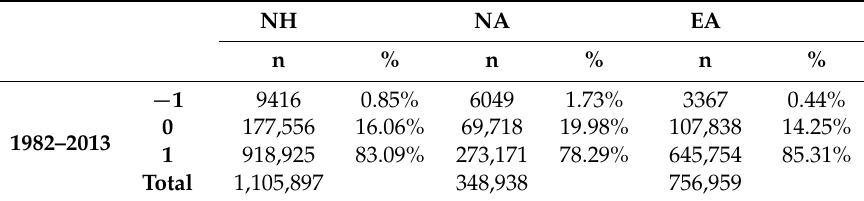
Figure 5. Map of r-values for correlations between length of vegetation growing season (LOS) and growing season NDVI integral (GSI) 1982–2013. Table 3. Statistics (number of pixels and percentages) of significant correlations between LOS and GSI (1982–2013) ( p = 0.1).